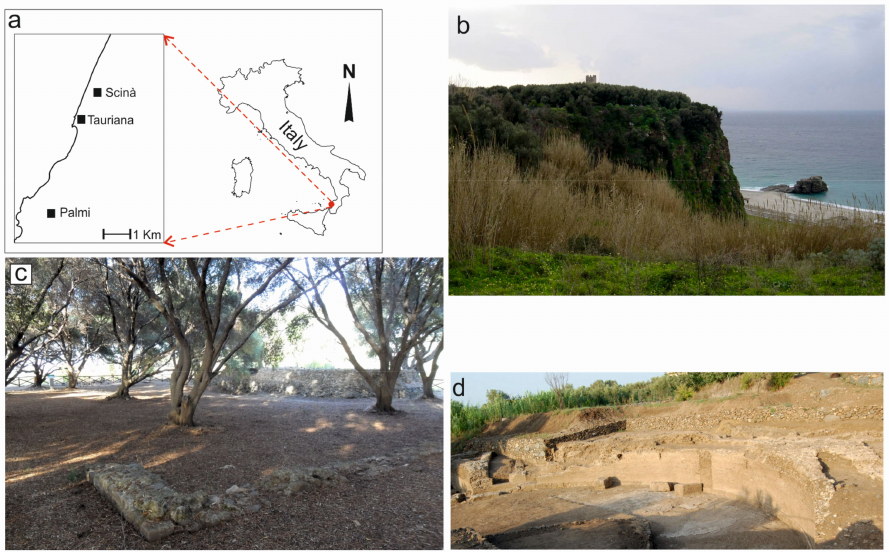
Figure 1. ( a ) Location of the Roman city of Tauriana (Reggio Calabria, Southern Italy); ( b ) Plateau overlooking the sea with the sighting tower of the 16th century; ( c ) Remains of the urban sanctuary; ( d ) Remains of the peculiar building for